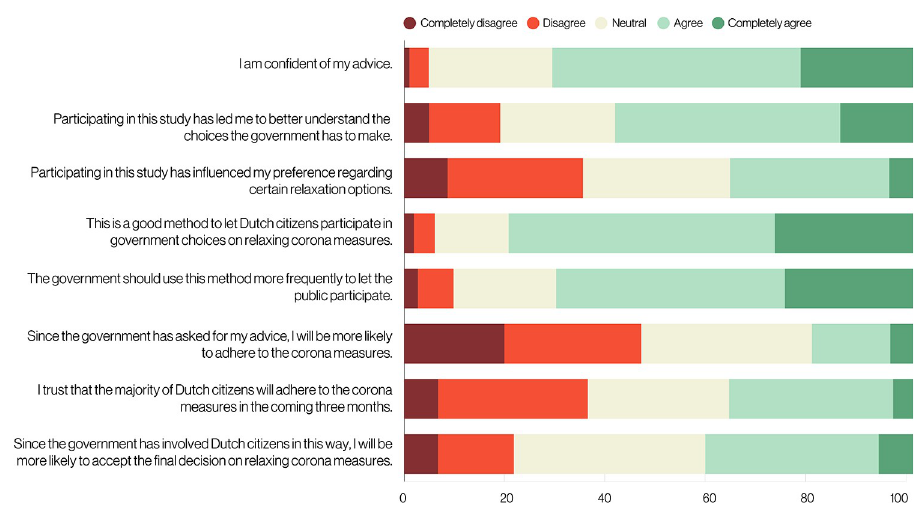
Fig 4. Experiences of participants and their likelihood of adherence/acceptance of measures.